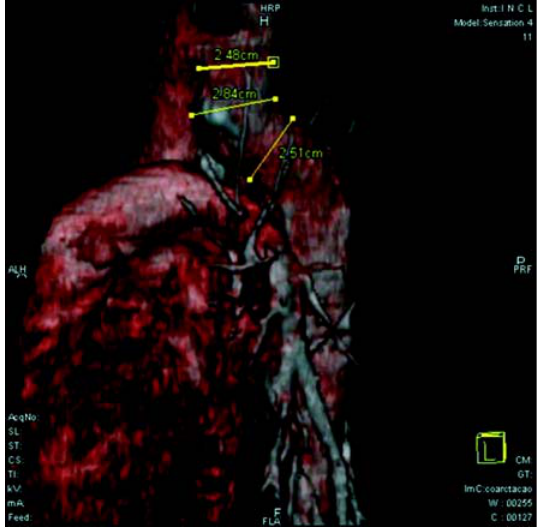
Fig. 7 – Angiotomografia torácica 18 anos após a cirurgia do paciente operado aos 13 anos de idade. Perfeito crescimento da região coartectomizada, sem qualquer sinal de re-coarctação